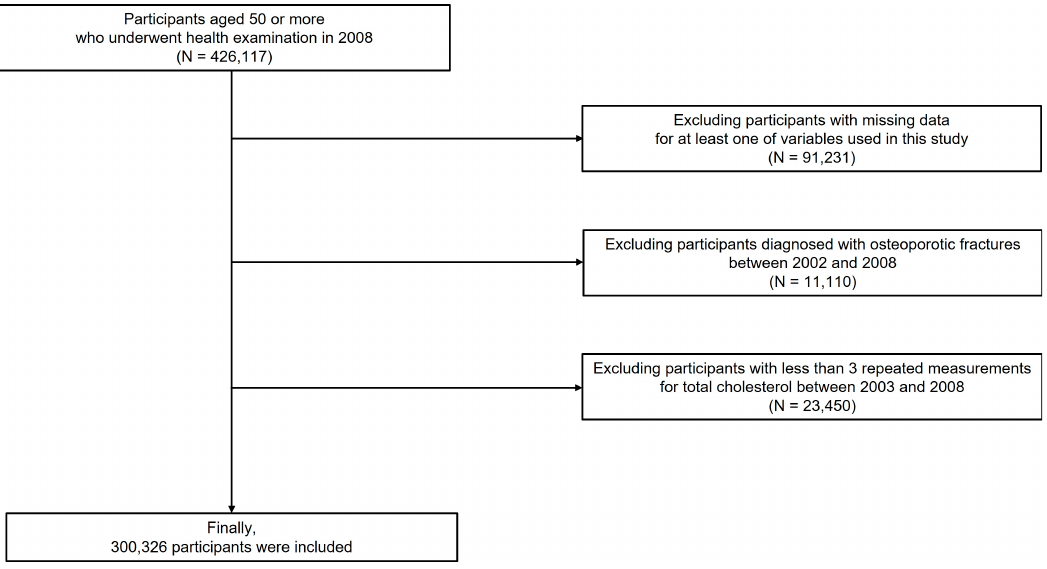
Figure 1. Flowchart of study subjects.